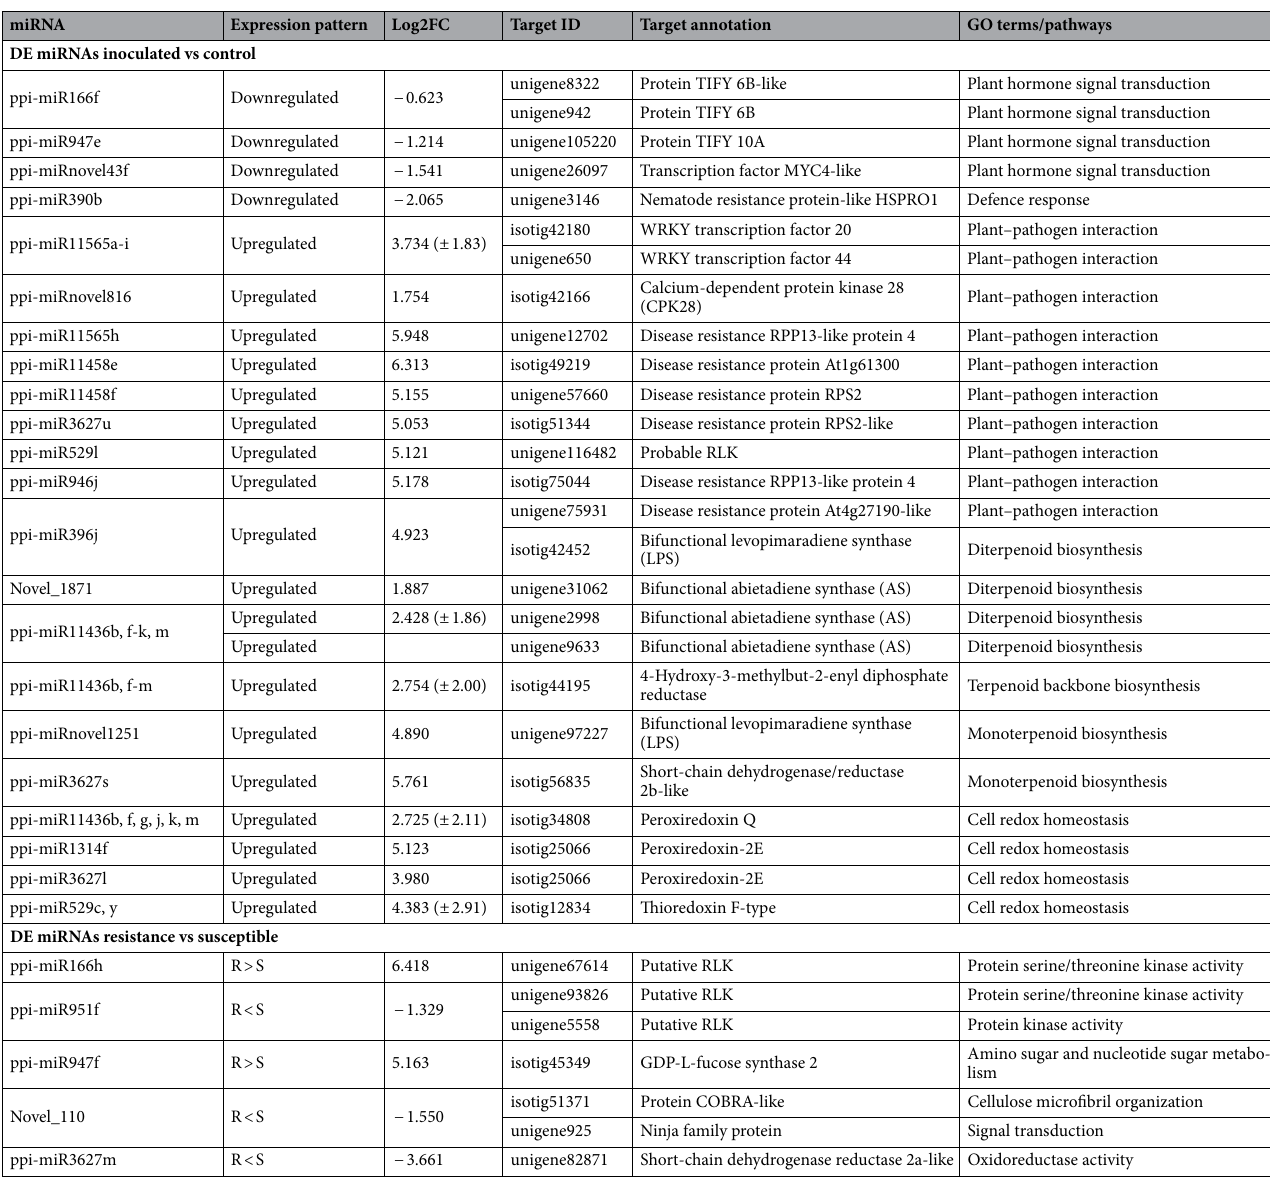
Table 3. Selected differential expressed P. pinaster miRNAs and predicted target